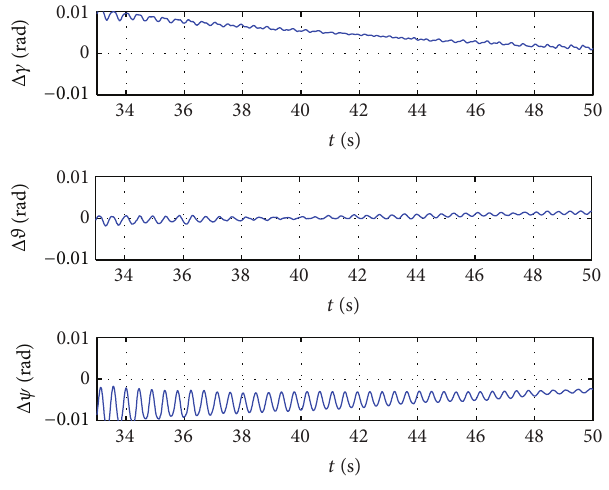
Figure 7: Partial magnification of attitude